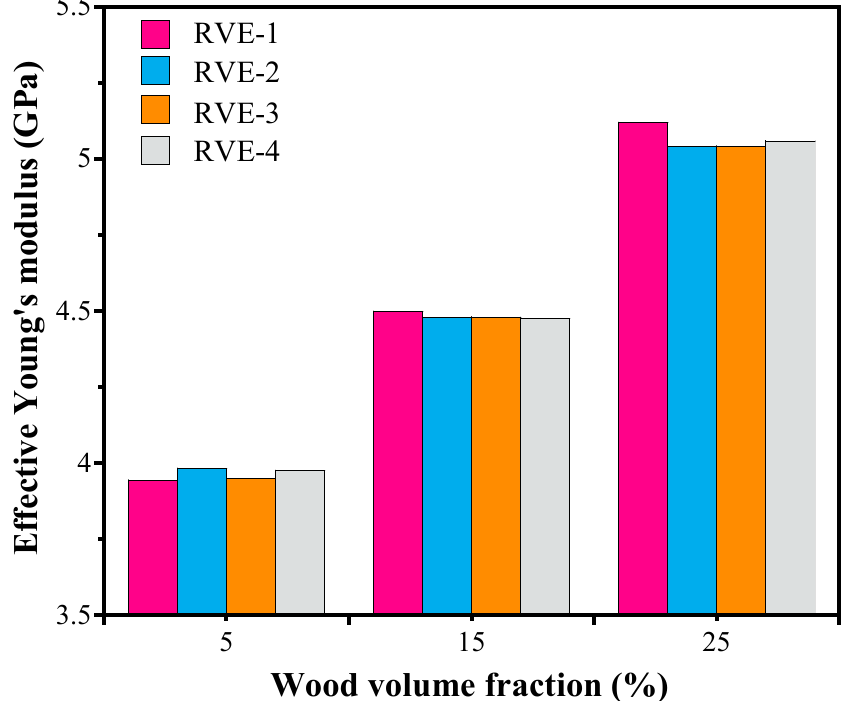
Figure 7. Variation of the effective Young’s modulus of four RVEs corresponding to different wood volume fraction (5%, 15%, and 25%).